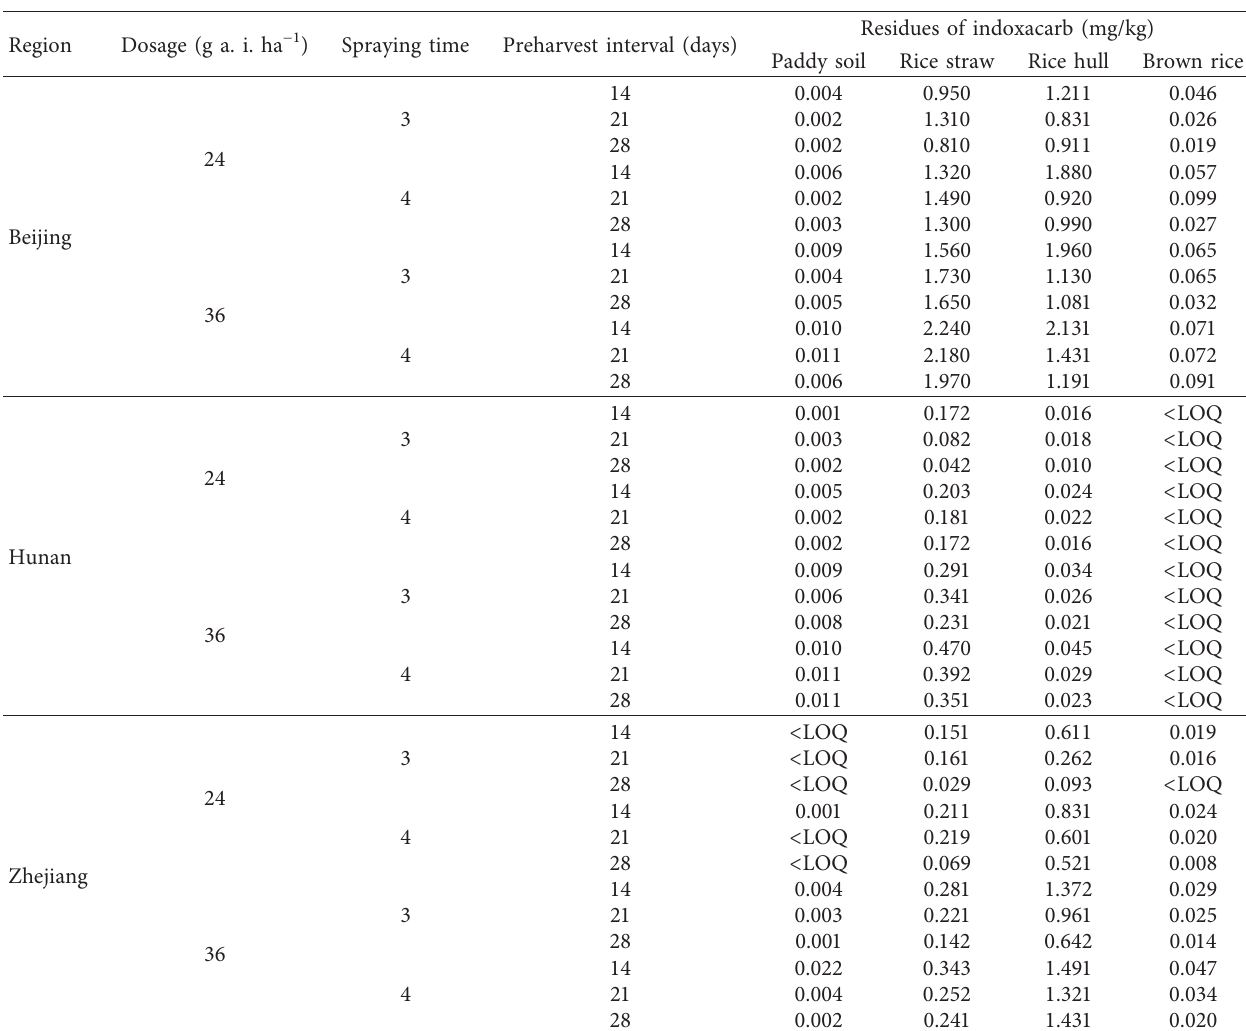
Table 6: Ultimate residues of indoxacarb in paddy soil, rice straw, rice hull, and brown rice (mg/kg).